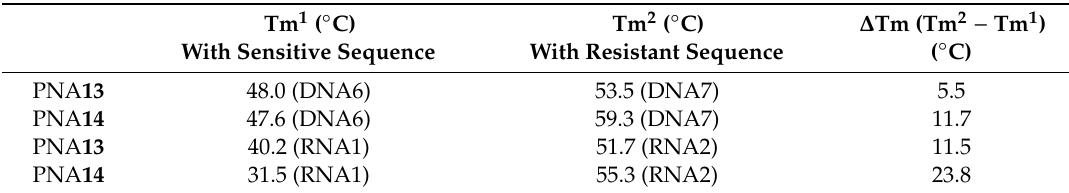
Table 7. UV-melting temperature analysis of PNA / DNA and PNA / RNA containing the neuraminidase inhibitor-resistant and neuraminidase-sensitive gene